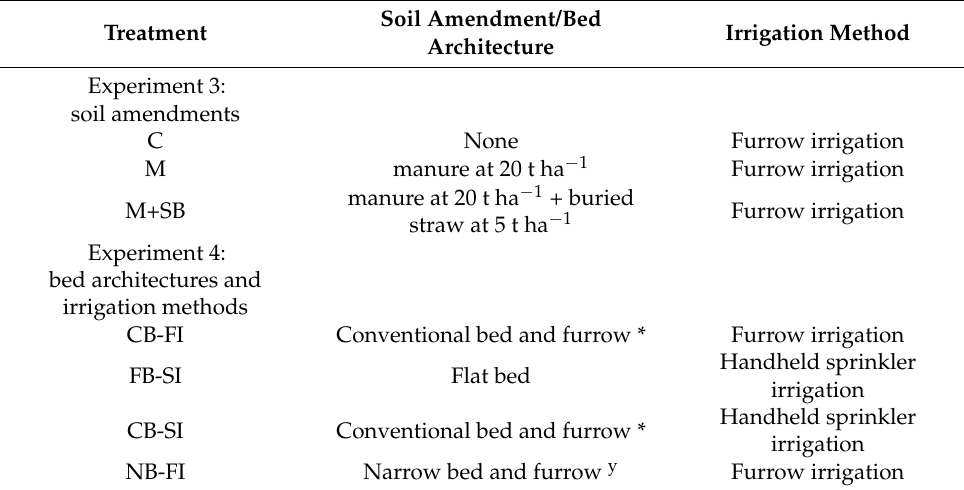
Table 1. Treatments applied in the experiments 3 and 4 conducted during the 2017/18 dry